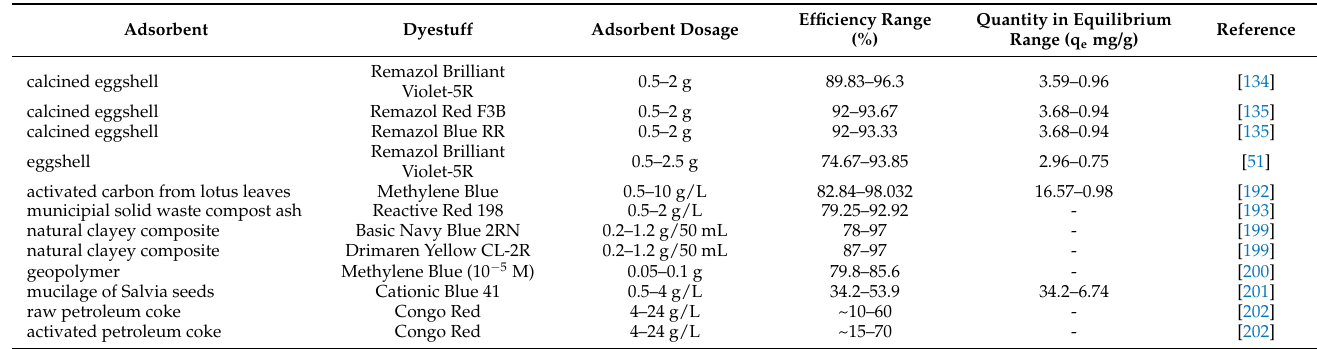
Table 4. Results of various research regarding the effect of adsorbent particle size.